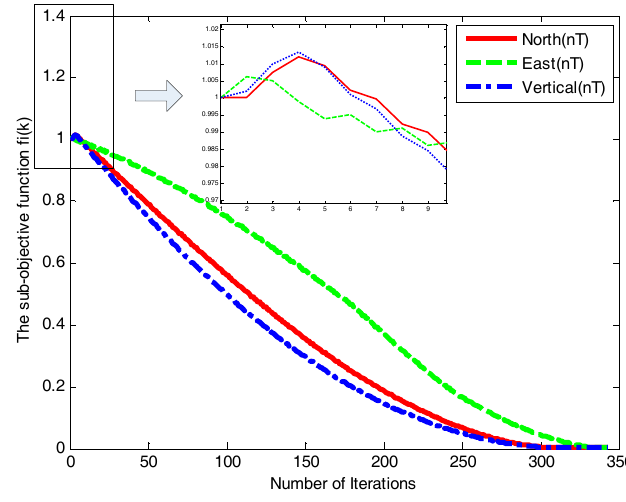
Figure 12. Three components convergence curves of the AMSA.